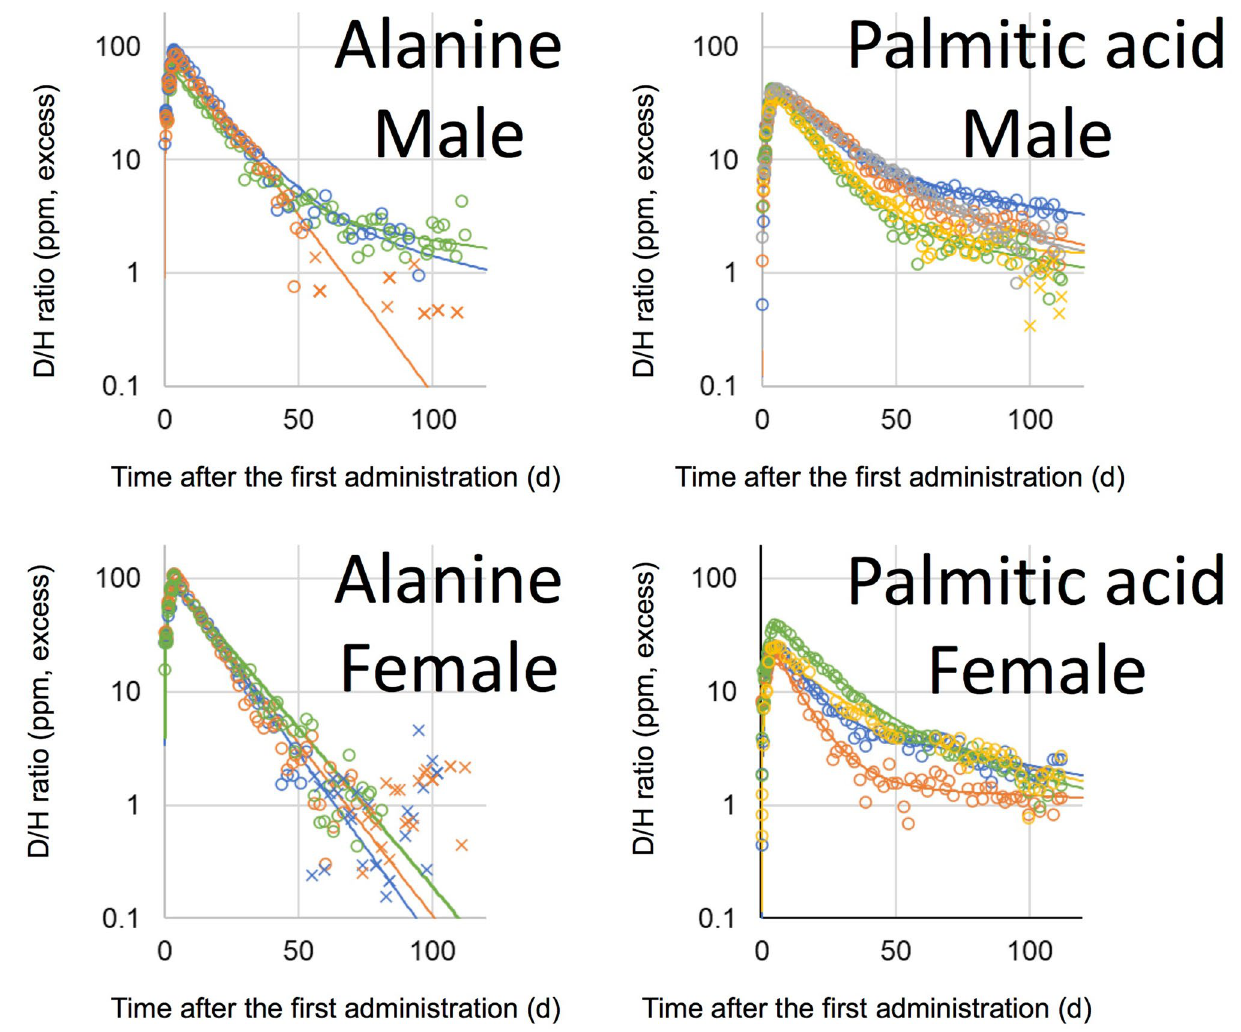
fitted using models shown in Fig. 1. Data below the 90% upper confidence limit of the background fluctuation for each volunteer, and the subsequent data after elimination from the fit, are shown by crosses. Each colour represents a different